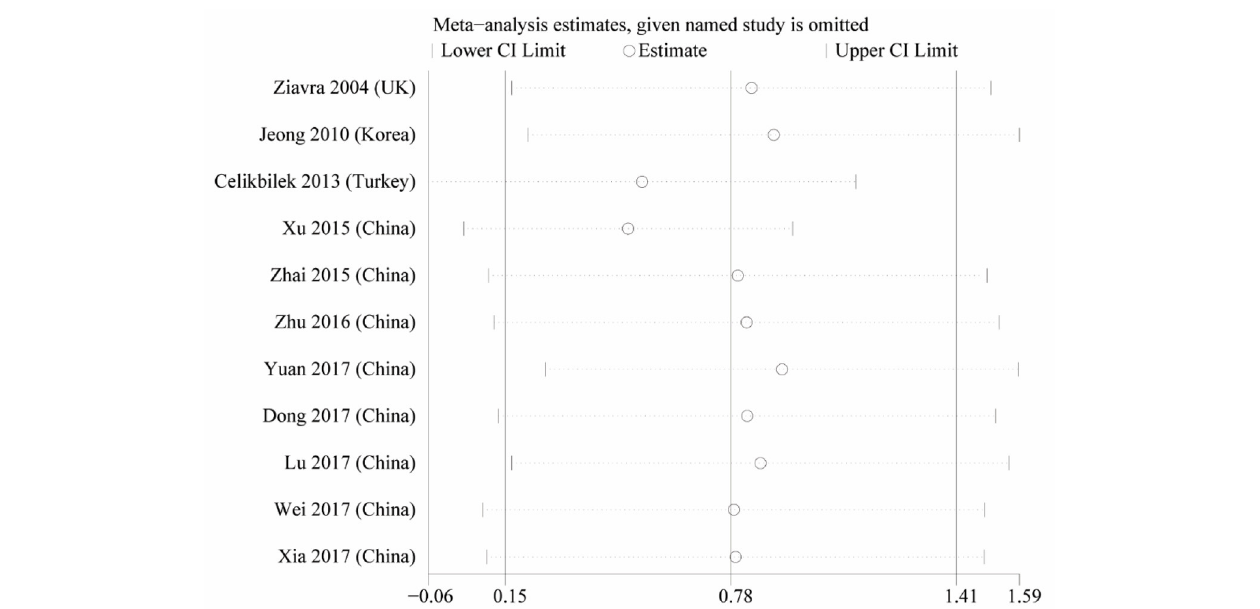
FIGURE 4 | Sensitivity analysis of the studies in serum uric acid level between the BPPV and control groups.